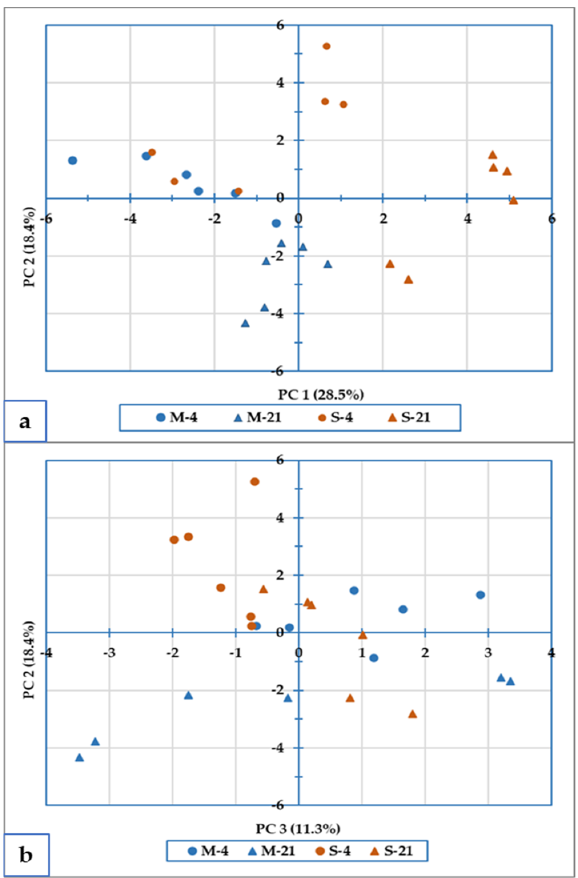
Figure 5. Biplot of the PCA considering the level of milk pasteurization (M and S) and cheese storage (4 and 21 days); ( a ) sca tt erplot in the PC1*PC2 space, and ( b ) sca tt erplot in the PC2*PC3 space. The used variables are reported in Tables 1, 3 and 4 for a total of 29 variables. M-4: 4-day-aged cheese from minimally pasteurized milk; M-21: 21-day-aged cheese from minimally pasteurized milk; S-4: 4-day-aged cheese from strongly pasteurized milk; M-21: 21-day-aged cheese from strongly pasteurized milk.